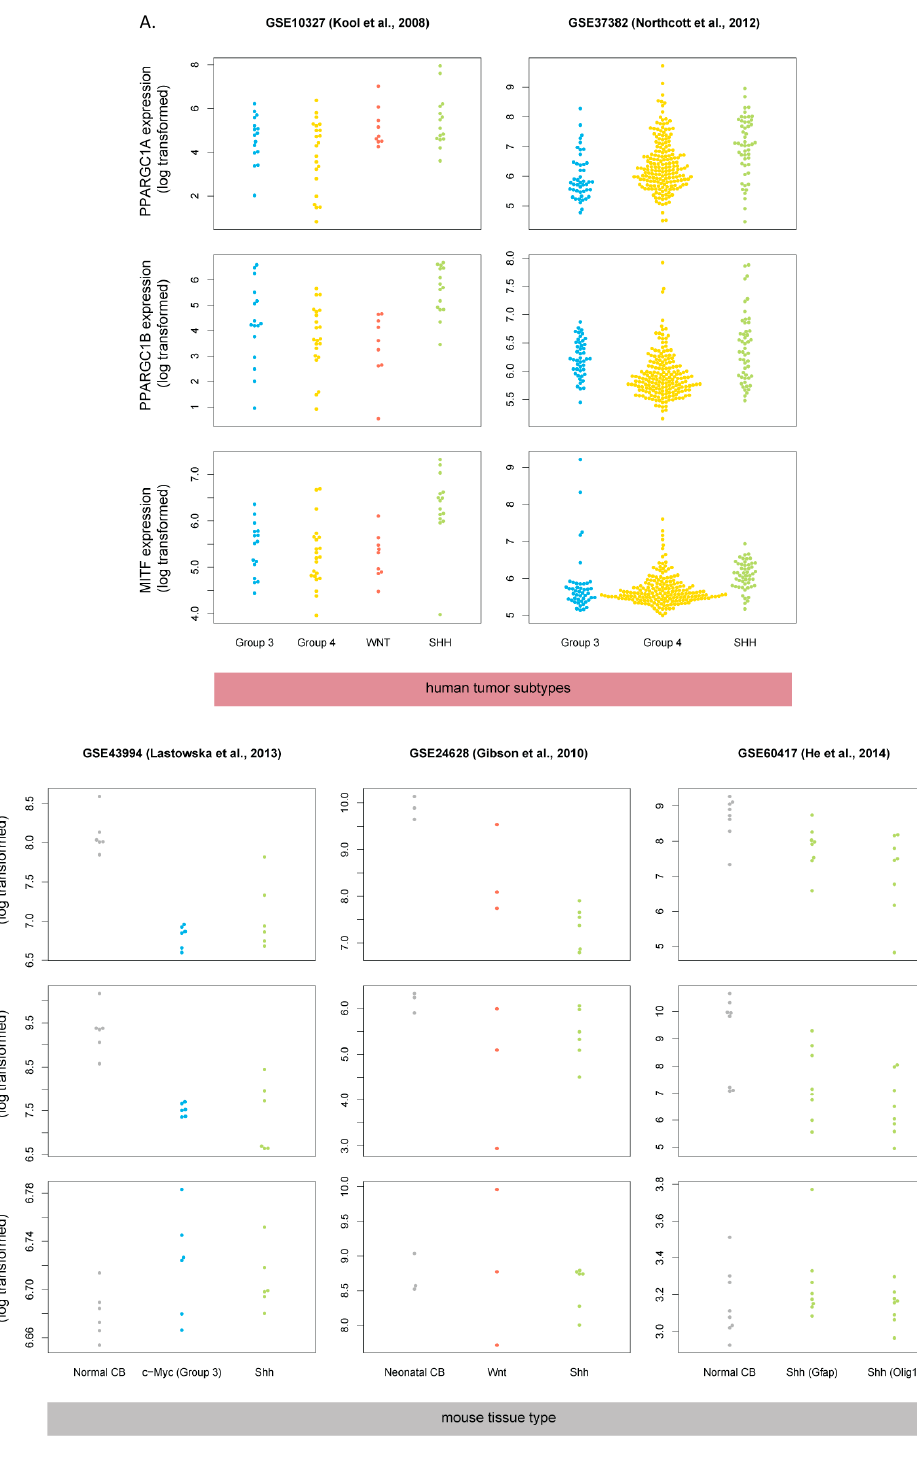
Figure 8. Oxidative phosphorylation master regulator genes are upregulated in human SHH-MB ( A ) but not in mouse Shh-MB ( B ). Expression data derived from microarray analysis were downloaded from GEO and processed as in Figure 2.